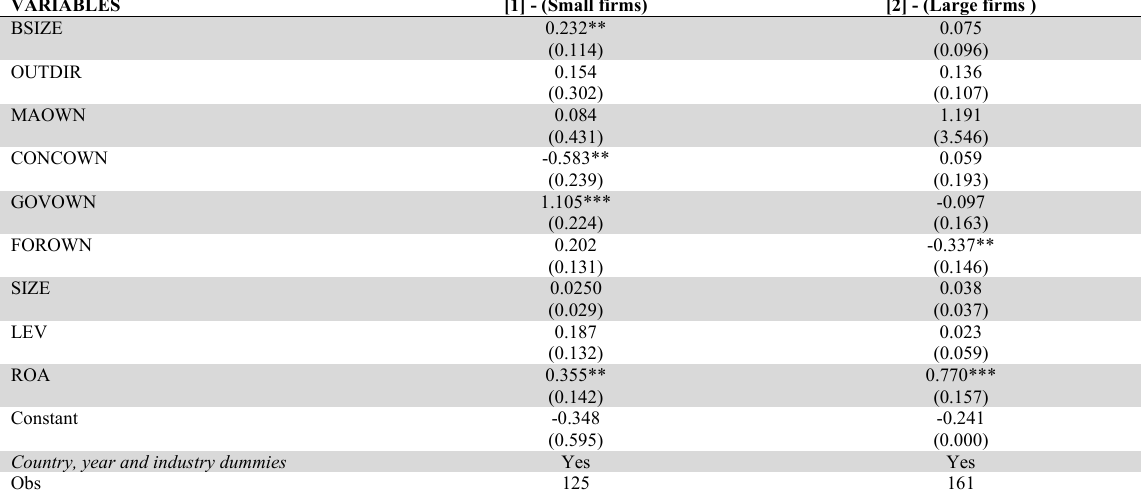
Firm size sensitivity analysis